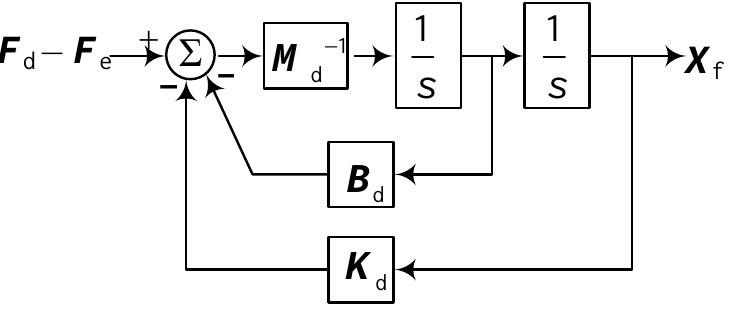
Figure 6. The structure diagram of the impedance control